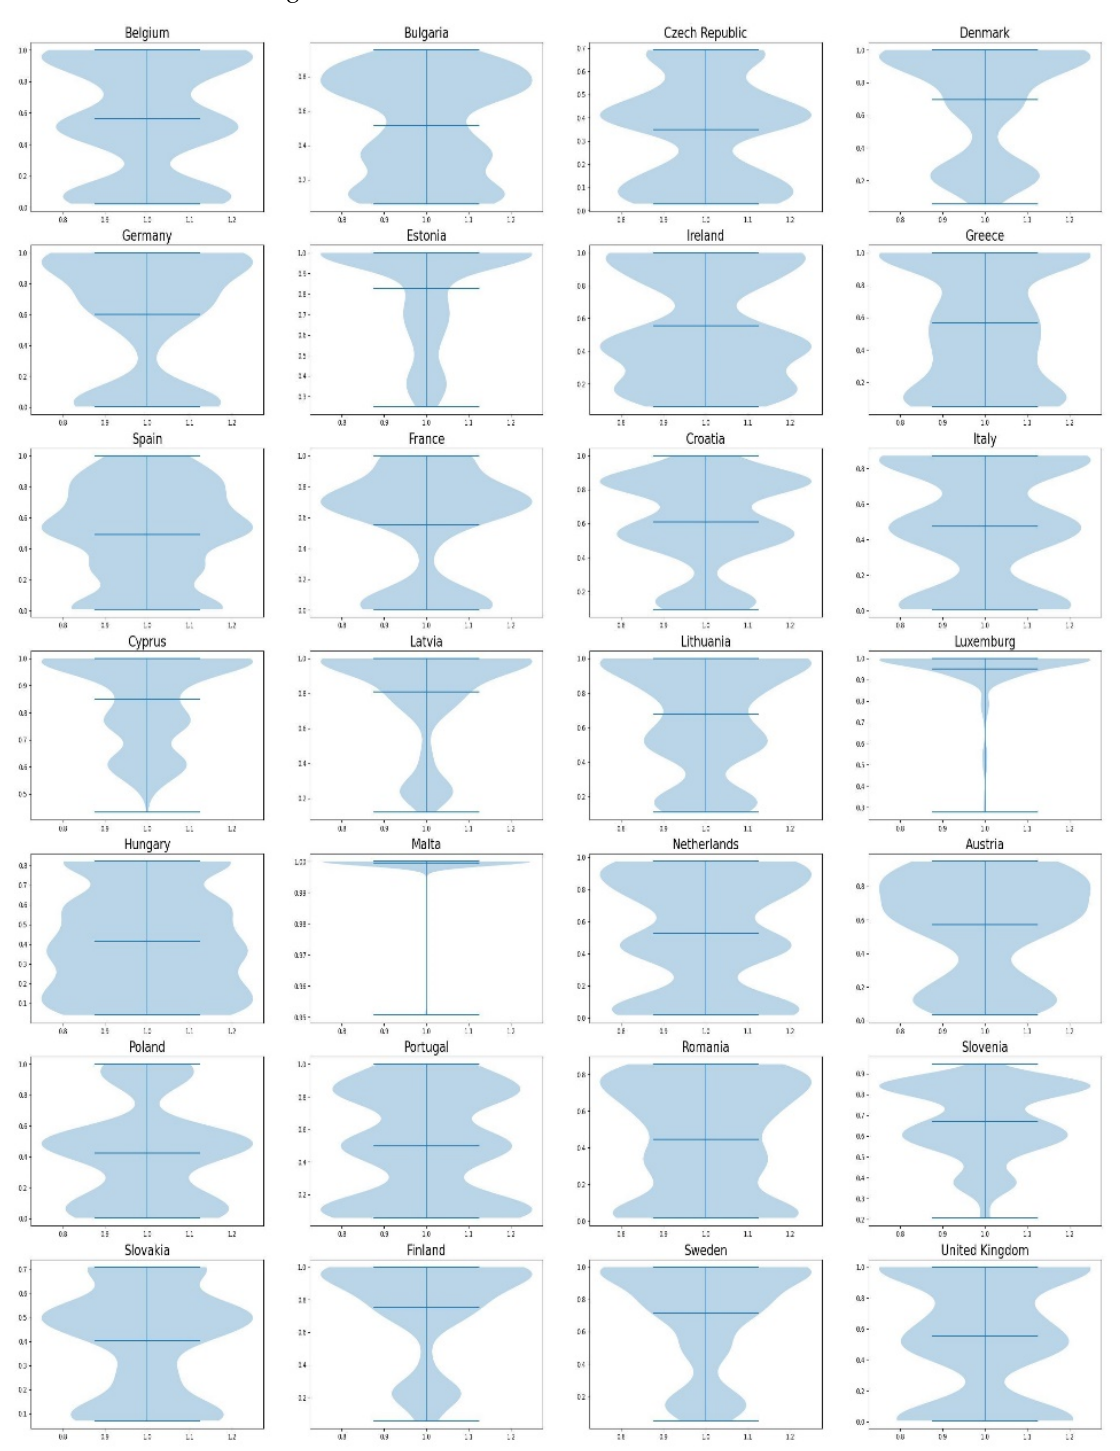
Figure 5. Violin plots of the sustainability of 135 different perceptions calculated with all DEA variations.